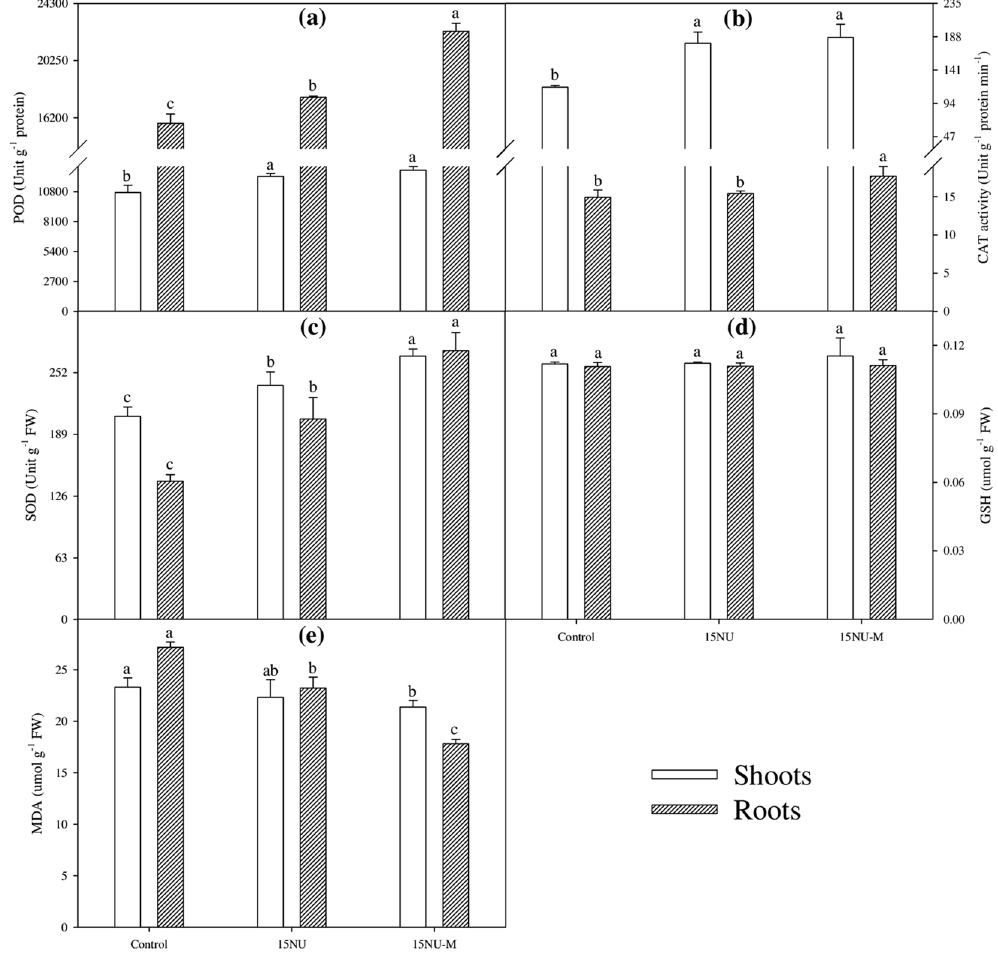
Figure 2. Effects of Chinese milk vetch on the activities of antioxidant enzymes in leaves and roots on 74 days after rice seedlings transplanting. ( a ) peroxidase (POD), ( b ) catalase (CAT), ( c ) superoxide dismutase (SOD), ( d ) reduced glutathione (GSH) and ( e ) malondialdehyde (MDA). FW: fresh weight. Values are means ± standard error (n = 3). Values followed by different letters in the same pattern bars are significantly different according to Tukey’s test at P ≤ 0.05.